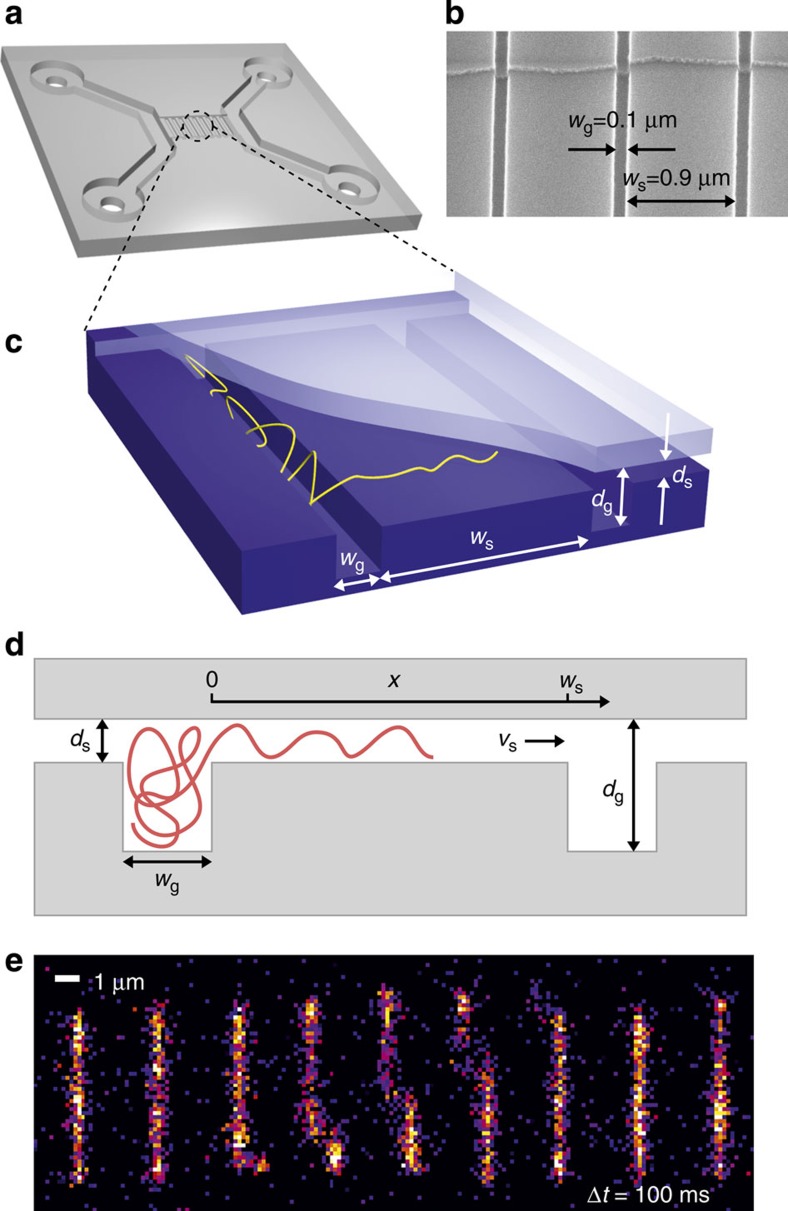
Experimental set-up.(a) Schematic drawing of the microfluidic device containing the
nanogroove array. A hydrodynamic flow (from left to right) is induced in the
chip by imposing a pressure difference ΔP over the chip.
Fluorescently labelled λ-DNA molecules (48.5 kb,
LDNA=21 μm) were introduced into the
nanogroove array by the flow. (b) Electron micrograph of a section of
a nanogroove array. (c) Schematic representation of a DNA strand
trapped in a nanogroove and attempting to cross the nanoslit separating two
grooves. The nanogroove geometry extends the DNA molecule transversally to
the flow direction. Consequently, escape into the nanoslit is initiated by
an end of the DNA. This vastly simplifies the dynamics compared with other
entropic trapping geometries where polymers tend to form herniations inside
the nanoslit. (d) Same as c, but showing a cross-section
perpendicular to the nanogrooves. The extent of the DNA molecule's end
inside the slit in the direction of the flow is called x. The
hydrodynamic drag force on the DNA is proportional to x and
υs, where υs is the mean
speed of the buffer flow inside the nanoslit. The relevant dimensions of the
nanogroove array are the height of the nanoslit,
ds≈50 nm; the total height of a nanogroove plus
the nanoslit, dg≈150 nm; the width of a
nanogroove, wg≈100 nm; and the width of a
nanoslit separating two grooves, ws=0.4, 0.9, 1.9,
3.9 μm. (e) Montage of fluorescence images of a DNA
molecule performing a sidewinder transition from one groove to the next21. The timelapse between consecutive images is 0.1 s.
The fluorescence intensity is indicated with false colours. Uneven
fluorescence of DNA in nanochannels is due to thermal fluctuations in the
density of DNA in channels, where it coils a little as indicated in
c. The lower fluorescence of DNA where it connects two channels in
frames 3–6 (counting left to right) is due to the DNA being stretched
in the slit, as indicated in c. Frame 7 shows the very last part of
the transition between channels/barrier crossing. a,b and
e are adapted from ref. 21.